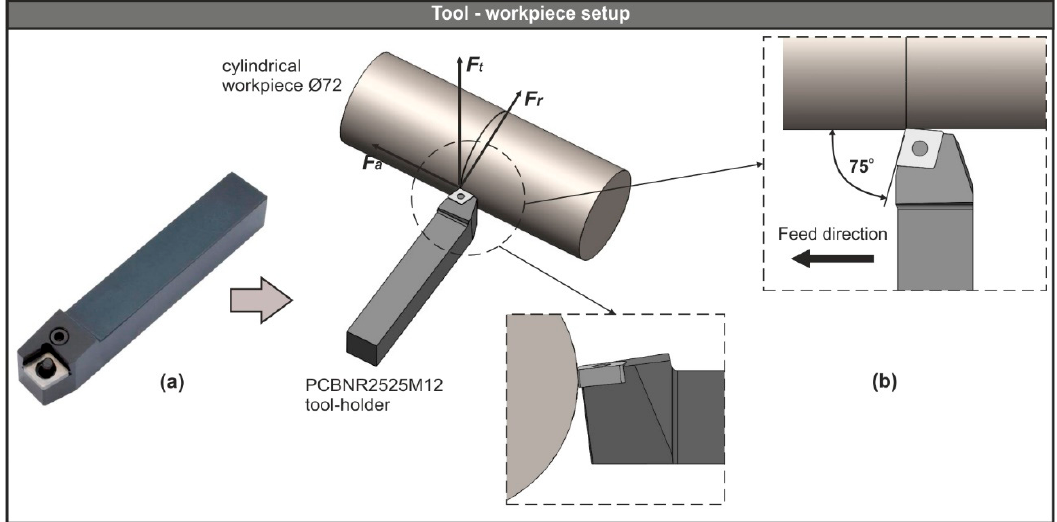
Figure 2. ( a ) The physical model of the PCBNR2525M12 tool-holder and ( b ) the CAD-based tool-workpiece setup.